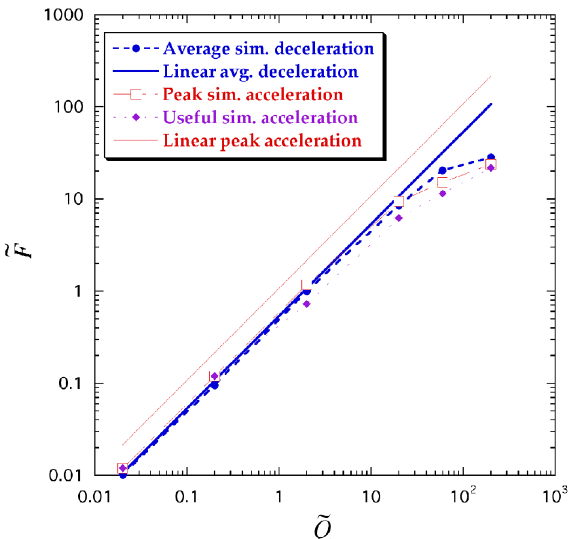
FIG. 7. (Color) The average normalized energy loss rate of ~ FF (cid:4) e jh E ij =m (cid:4) 0 : 1 ; ~ aa (cid:4) c! of an electron beam with ~ ll z e p z dec 0 : 2 , as a function of ~ QQ , from linear theory (solid bold line) and self-consistent PIC simulation (circles), the peak accelerating (cid:4) e j E j =m c! , from linear field behind the beam, ~ FF z; max e p max theory (solid fine line) and PIC simulation (squares), and the useful field for acceleration (diamonds), defined by the geome- try in